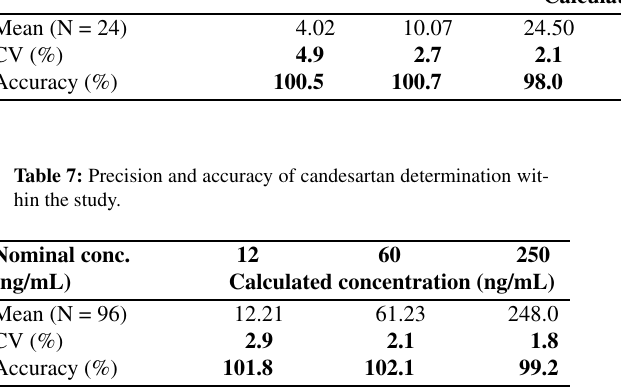
Table 6: Linearity of candesartan determination within the study. Nominal conc. (ng/mL)